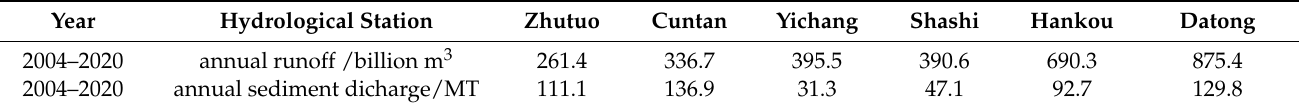
Table 3 exhibits the average annual runoff and sediment discharge data from Zhutuo, Cuntan, Yichang, Shashi, Hankou, and Datong, along YR. Table 3. Average runoff and sediment discharge in